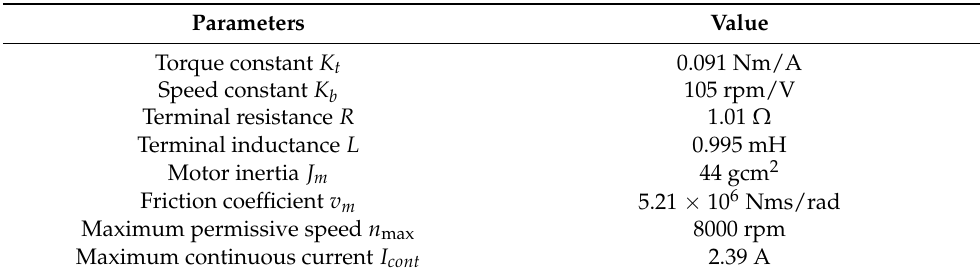
Table 2. Motor parameters of the Eci-40 Maxon brushless DC